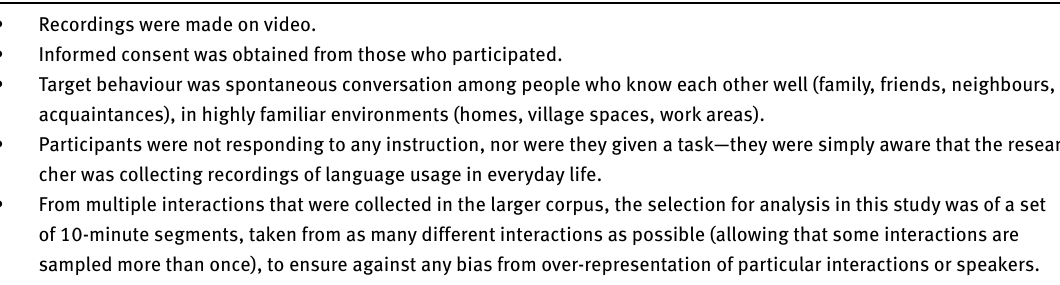
Table 1: Key properties of the data collected for this